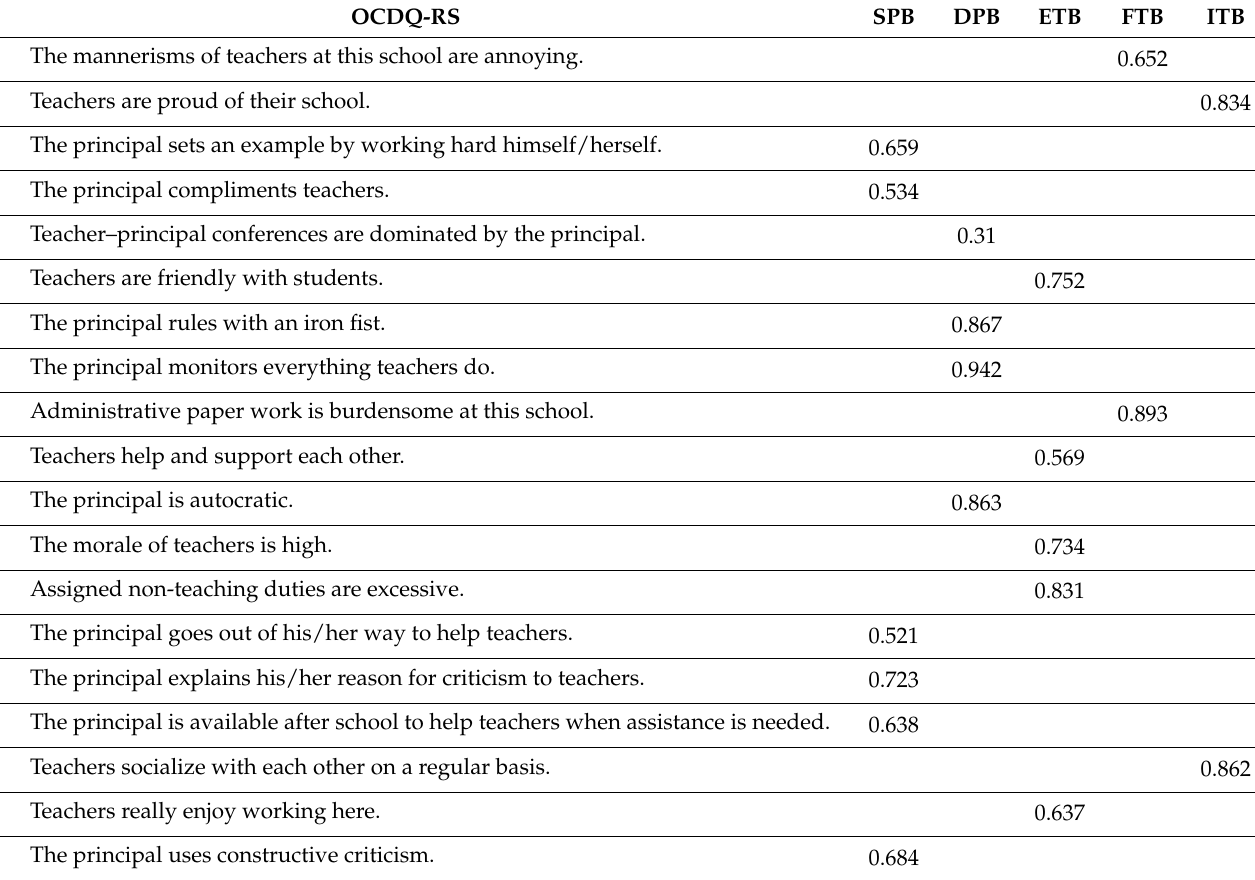
Table 2. Saturation of the extracted dimensions by the items of the